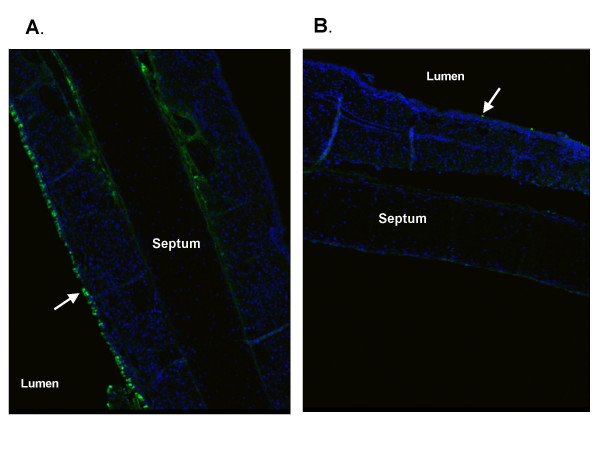
Distribution of FITC-labelled asODN in the mouse nose in vivo. FITC-labelled asODN (80 μg/mouse) were complexed with GL67 and perfused into the nasal cavity. Twenty-four hours later the nasal septum was extracted, paraffin-embedded and processed for confocal microscopy. Nuclei are shown in blue, FITC signal is shown in green. Arrows indicate the surface epithelium. A and B are images from two different animals showing the highest (A) and lowest (B) levels of uptake seen.